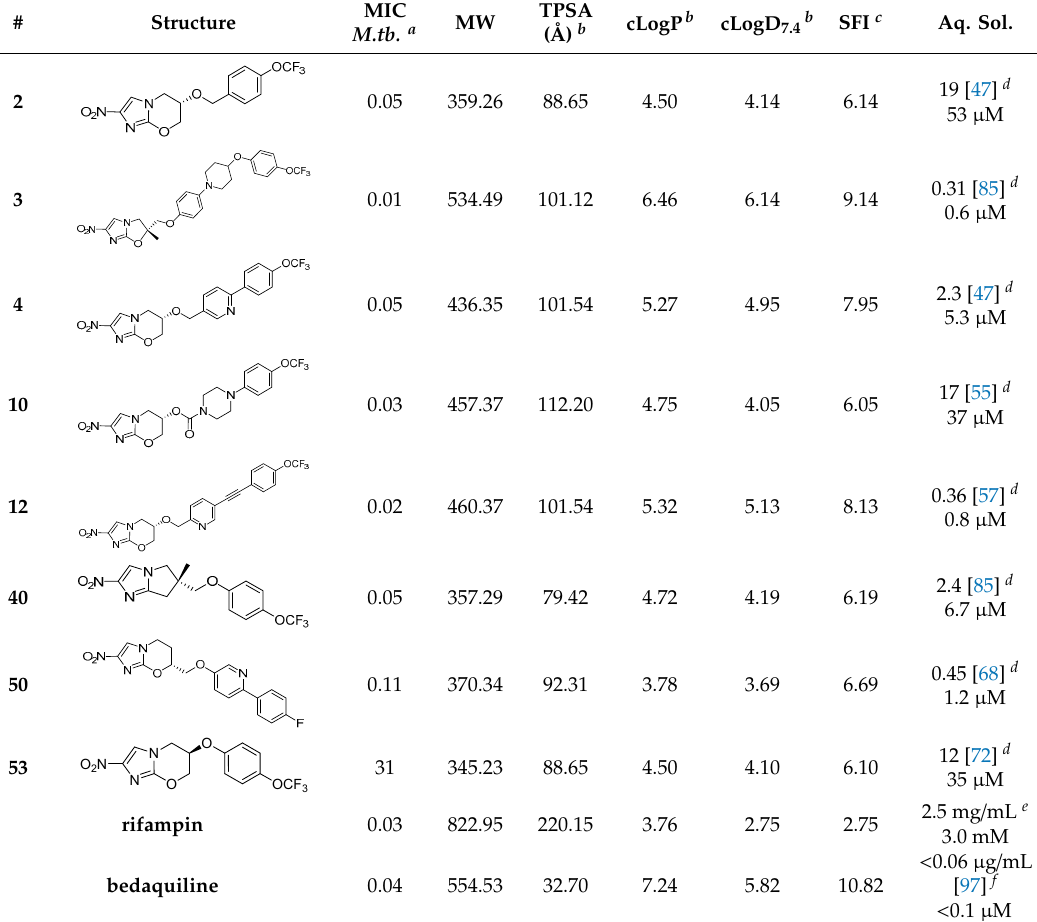
Table 1. Computed properties of selected bicyclic